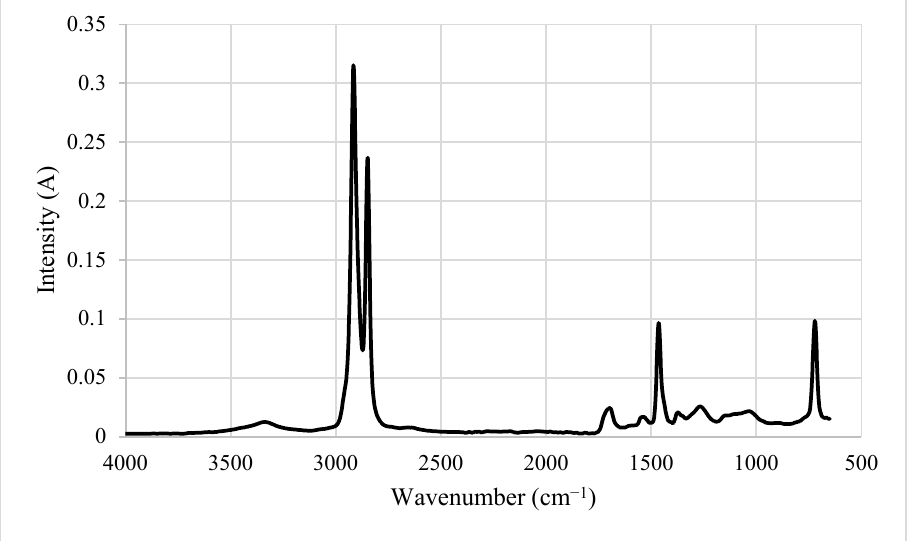
Figure 2. FT-IR spectrum of the dry pulp from cardboard (CBDP), where wavelength (in wave numbers: cm − 1 ) are plotted against signal intensity (in arbitrary units).